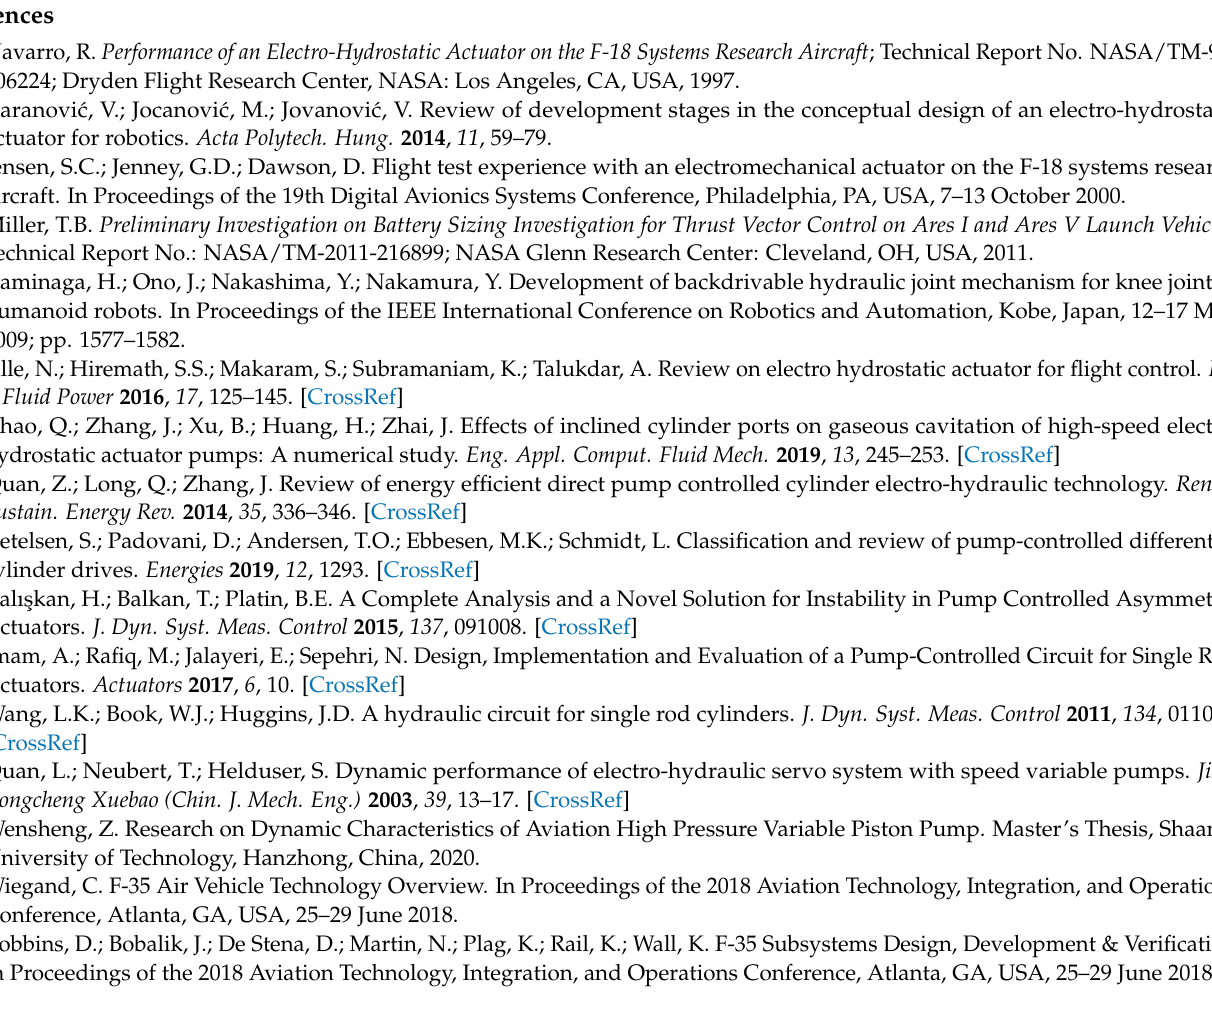
pressure difference in the top and bottom dead points transition